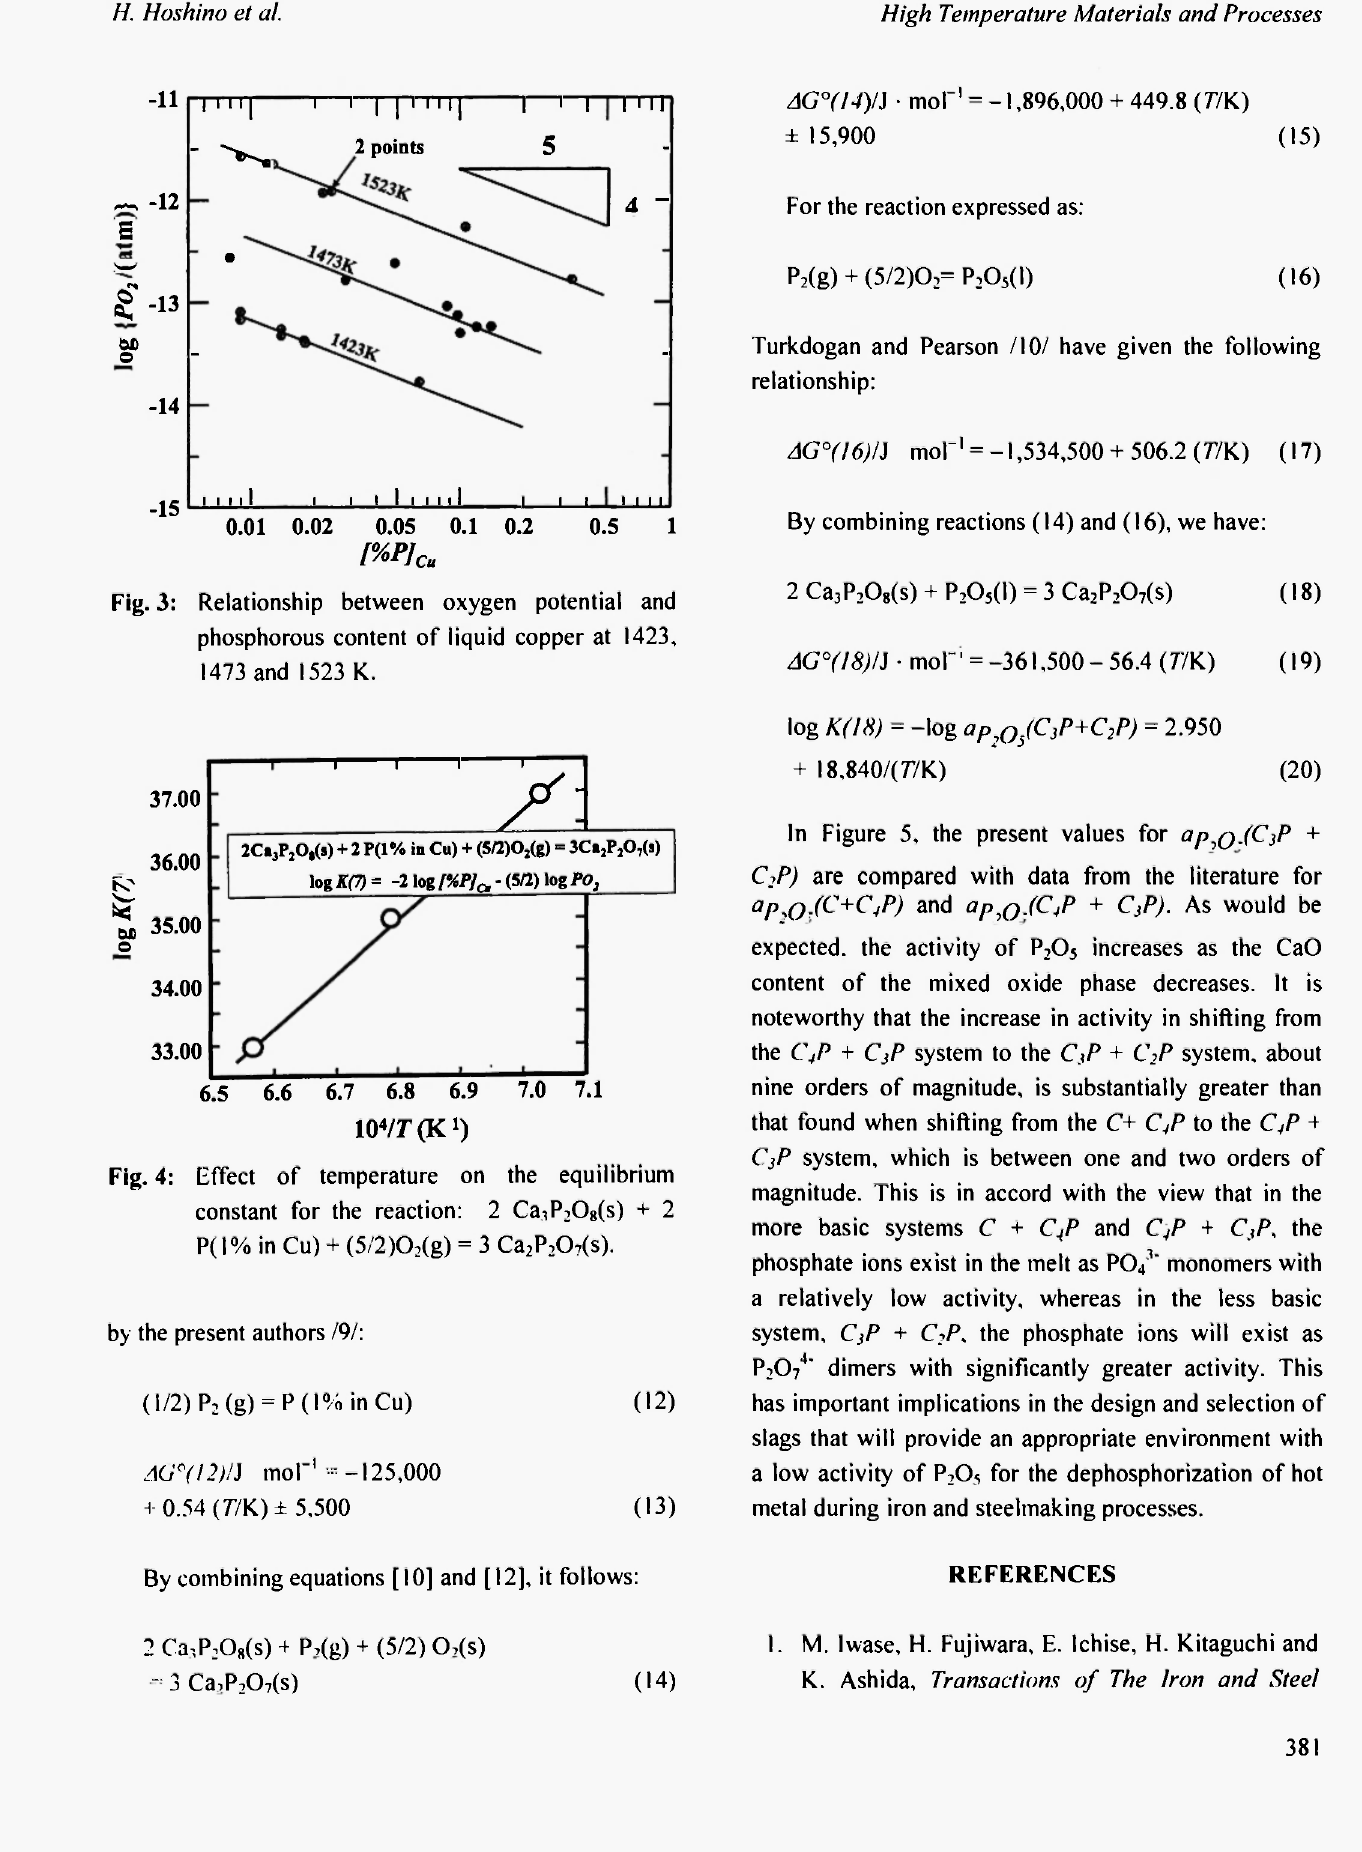
Fig. 3: Relationship between oxygen potential and phosphorous content of liquid copper at 1423, 1473 and 1523 K.